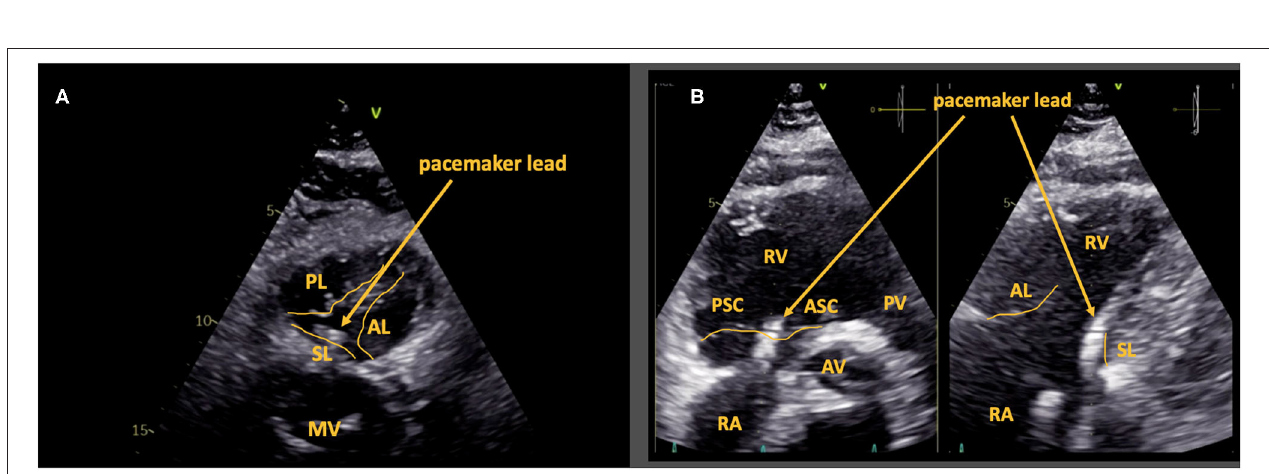
FIGURE 2 | Case 1: Septal leaflet impingement by pacemaker lead. Central lead position with impingement of the septal leaflet is shown via subcostal en face view of the tricuspid valve (A) and via the commissural view in the parasternal short axis ( B ; left side) and the corresponding 90 ◦ view of the septal and the anterior leaflet ( B ; right side). AL, anterior leaflet; PL, posterior leaflet; SL, septal leaflet; RA, right atrium; RV, right ventricle; PSC, postero-septal commissure; ASC, antero-septal commissure; MV, mitral valve; PV, pulmonary valve; AV, aortic